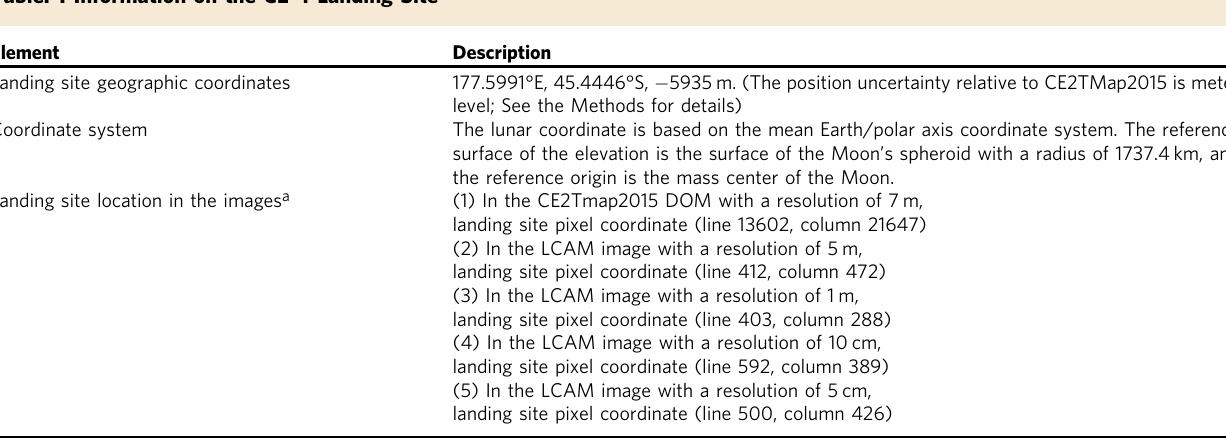
Table. 1 Information on the CE-4 Landing Site Element Description Landing site geographic